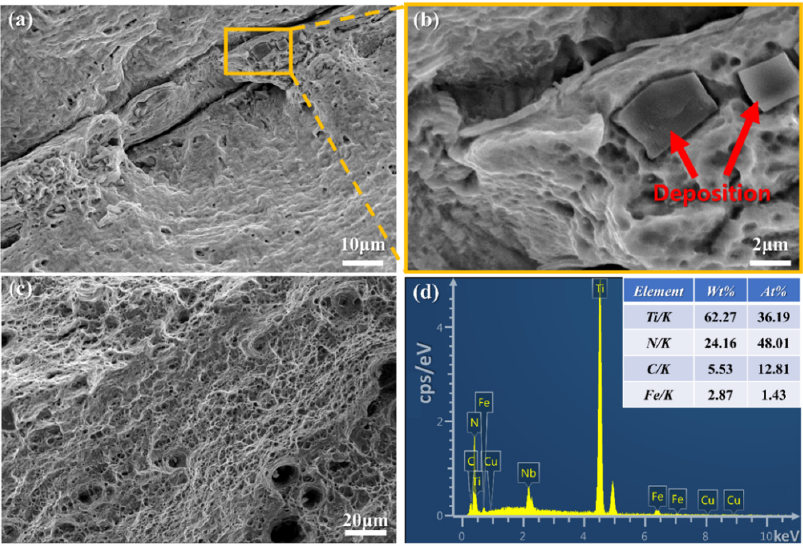
Figure 12. T max = 1250 °C, t 8/5 = 4 s: ( a ) precipitates; ( b ) enlarged view; ( c ) microstructure; ( d ) EDS analysis of particles presented in ( b ).